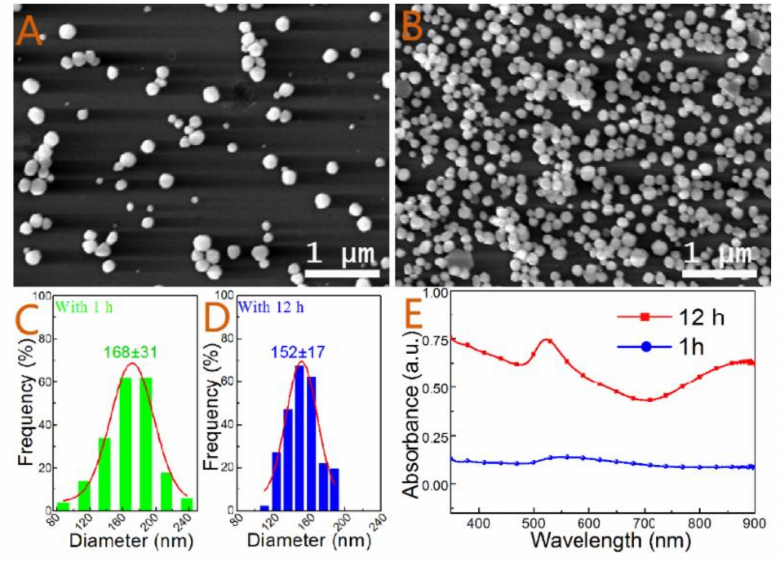
Figure 2. SEM images of the substrates with immobilized Au NPs without activation process at different immersion times: ( A ) 1 h and ( B ) 12 h. ( C ) and ( D ) Particle size distributions of Au NPs in ( A , B , E